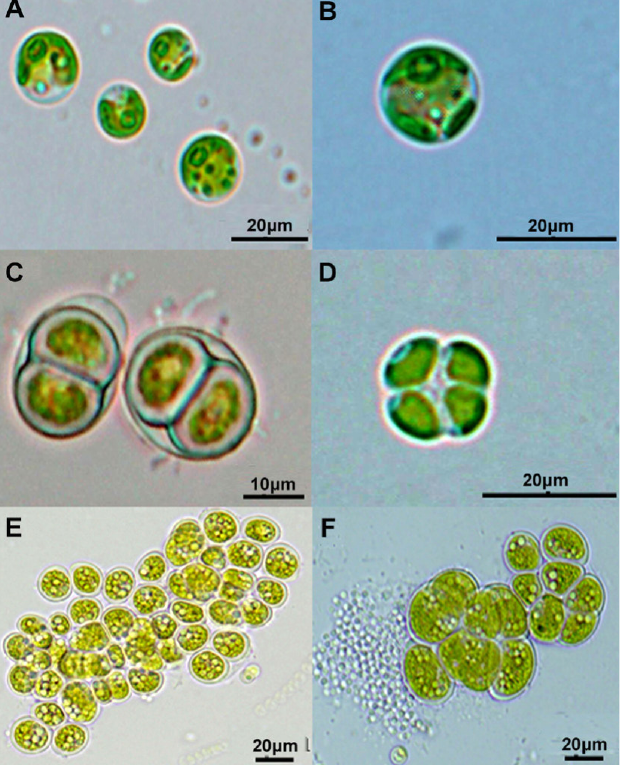
Fig. 2: Light microscopical images of TY02. (A-B) unicellular, (C-D) autospores formed, (E-F) palmella.